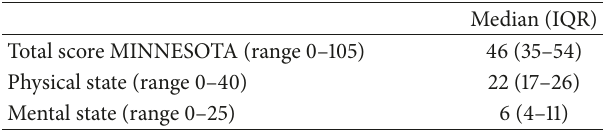
Table 3: Measuring impact of heart failure on quality of